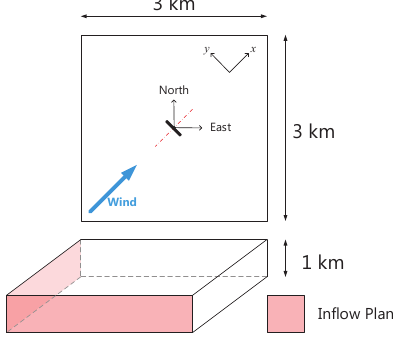
Figure 1. Dimensions of the computational